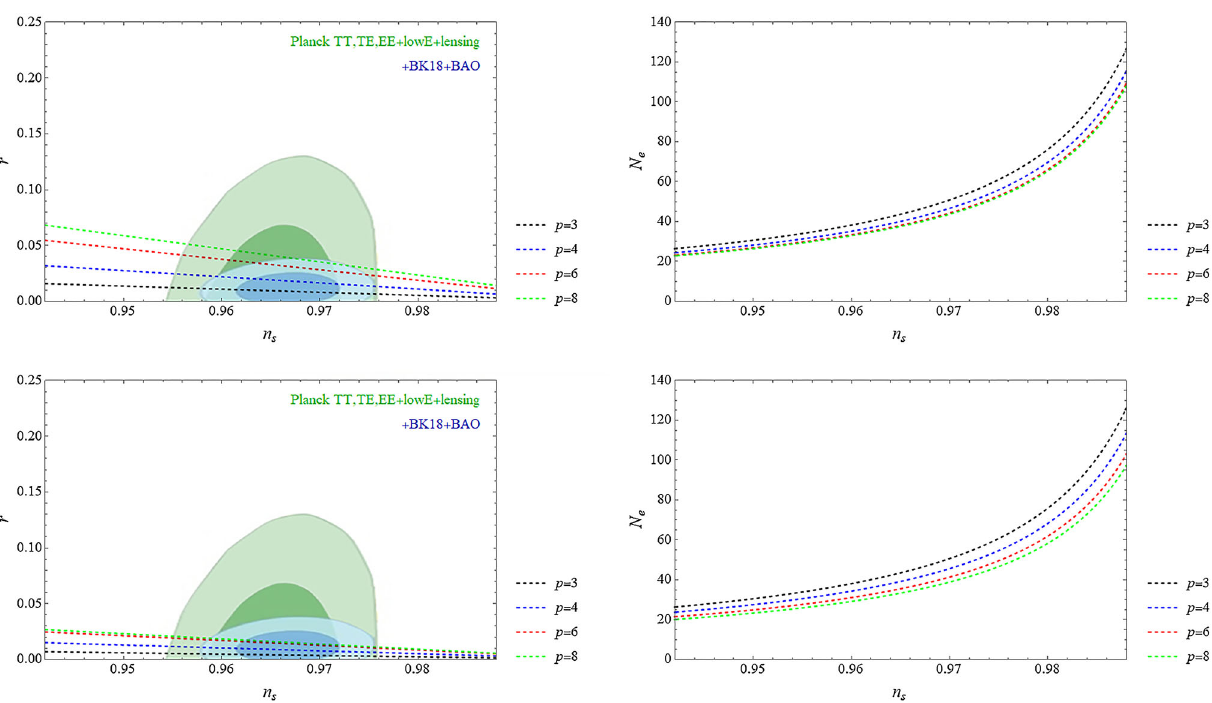
c = 0 lie within the 68 or 95% confidence regions of the Planck 2018 TT, TE, EE + lowE + lensing + BK18 + BAO data. In addition, all curves of r ( n s ) for c = 0 . 5 lie within the 68% confidence region of the Planck 2018 TT, TE, EE + lowE + lensing + BK18 + BAO data. More details on the